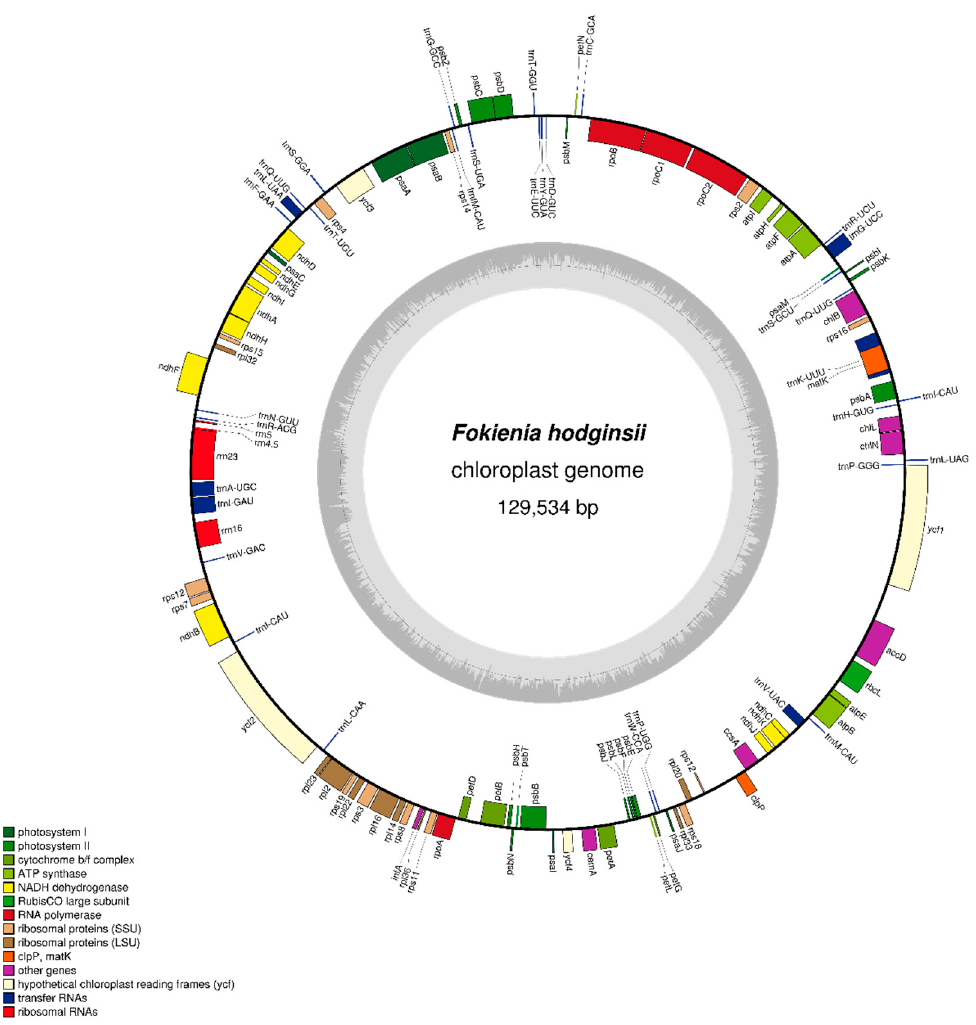
Figure 1. Gene map of the F. hodginsii cp genome. Genes drawn outside the circle are transcribed clockwise, while those shown inside are transcribed counter-clockwise. Genes were coded with diversified colors to distinguish their different functional groups. The darker and lighter gray circles represent GC and AT contents, respectively.